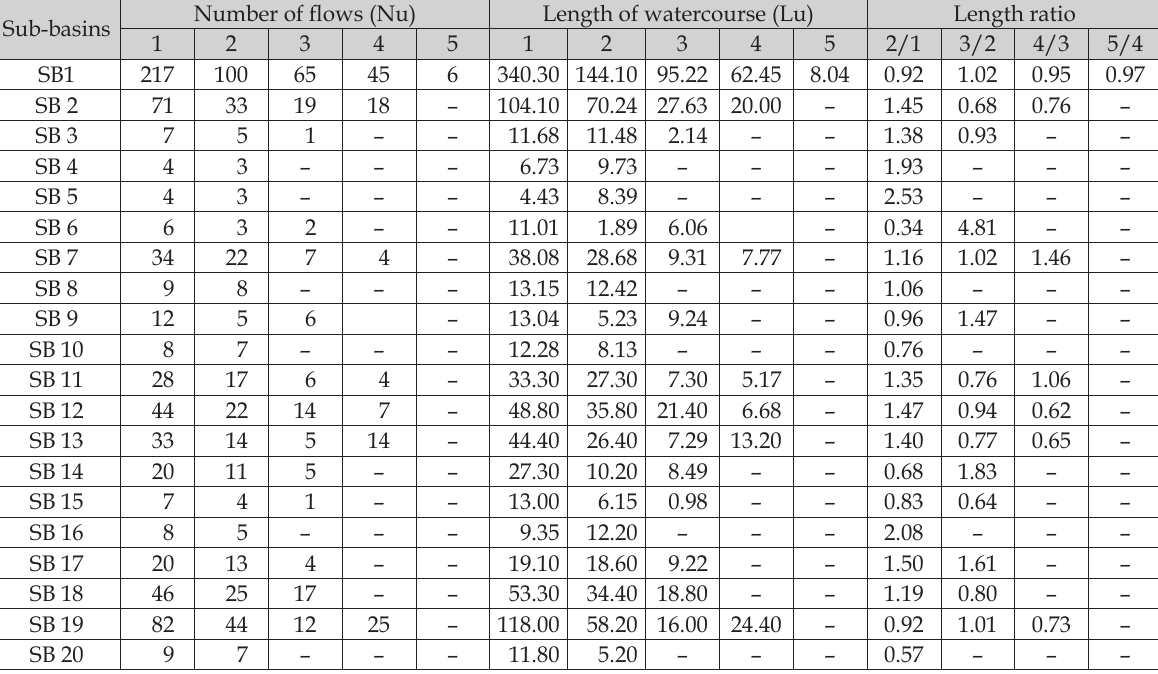
Table 2. Current analysis of the sub-catchments of the Soungrougrou catchment.